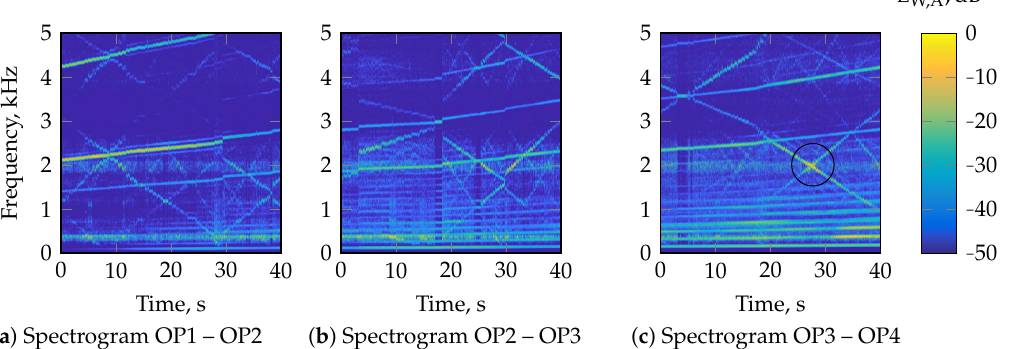
Figure 11. L W,A of the electric powertrain between neighboring operating points relative to the highest sound power level in the respective measurement range. The black circle marks a detail of a crossing characteristic in the